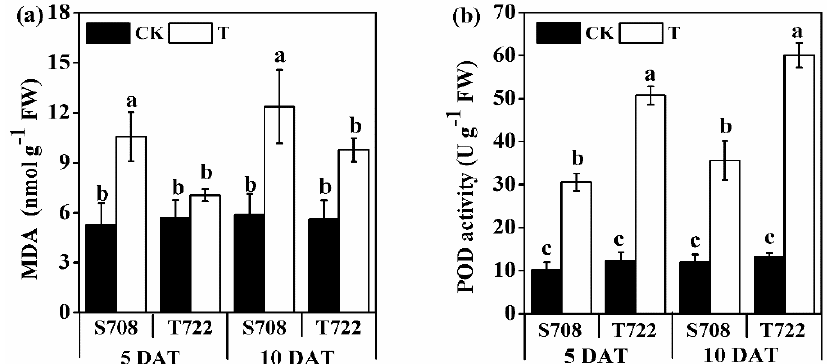
Figure 2. Physiological responses of the two tomato cultivars to sub-optimal temperature. ( a ) MDA content and ( b ) POD activity of S708 and T722 cultivars grown at normal temperature (CK, 25/18 ° C) and sub-optimal temperature (T, 15/10 ° C) at 5 and 10 DAT. Data are the means with standard deviation shown by vertical bars (n = 3 representing 3 biological replicates). The different small letters above the bars represent significant differences attested by the Tukey’s HSD test ( p < 0.05).